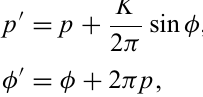
FIG. 5. Standard map on the Bloch square: quantum states ( p , φ) ∈ [0, 1] × [0, 2 π ] iterated at K = 1.15 over a uniform grid of initial conditions. Left: initial distribution n = 0: homogeneous distribution with 30 2 points ( p 0, . . . , 29 running over all initial conditions, each distinctly colored. Middle: after only n = 25 iterations the points begin to mix, according to whether they lie in regions of periodic, quasiperiodic, or chaotic behavior. Right: the long-term distribution, after n = 1000 iterations. The full range of behaviors is evident.